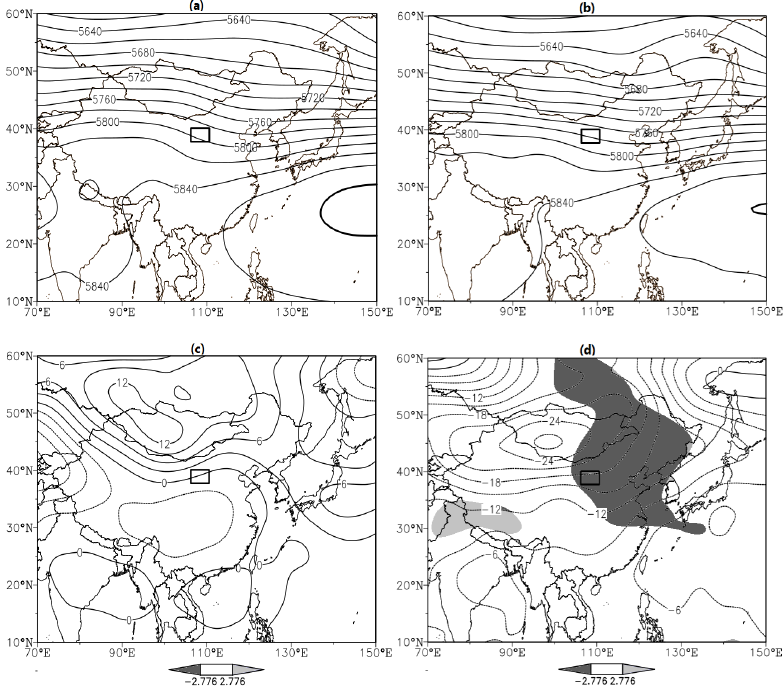
Figure 6. 500 hPa average geopotential height field ( a , b ) and anomalous geopotential height field ( c , d ) in the summer of the typical drought years ( a , c ) and flood years ( b , d ). (Unit: